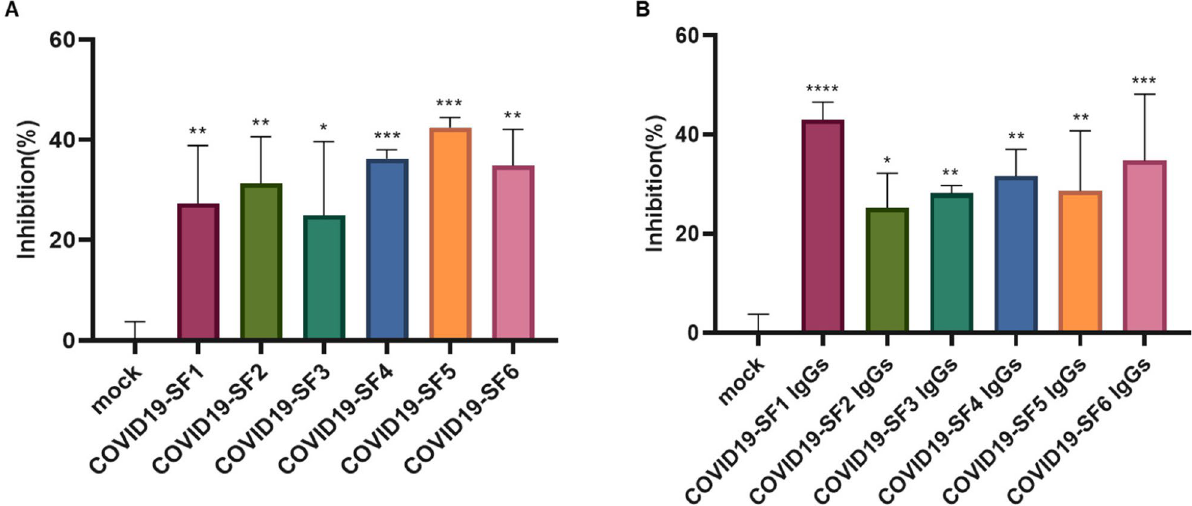
Figure 7. The effect of S protein fragments and their antiserum on pseudovirus infection to the cells. ( A ) Six protein fragments (1 μM) of SARS-CoV-2 were incubated with pseudovirus (650 TCID 50 ) and hACE2-293T cells, and infection was analyzed by the luciferase system. ( B ) IgGs (10 μg/mL) against 6 protein fragments of SARS-CoV-2 were incubated with pseudovirus (650 TCID 50 ) and hACE2-293T cells, and infection was analyzed by the luciferase system. The luciferase in the cells was quantified by a microplate luminometer. The Y-axis of the graphs represents the mean percentage of inhibition of virus yield. Inhibition rate was normalized based on uninfected cells as 100% inhibition and cells infected with pseudovirus only (mock) as 0% inhibition of the luciferase activity. Values were shown as mean of triplicates ± SD; * p < 0.05, ** p < 0.01, *** p < 0.001, **** p < 0.0001 by one-way